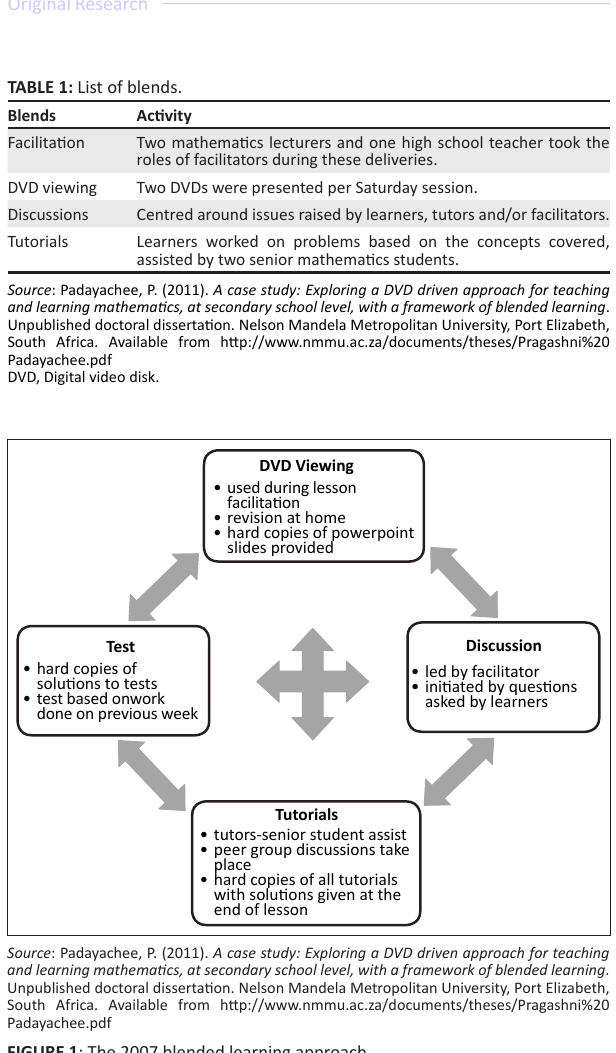
FIGURE 1 : The 2007 blended learning approach.